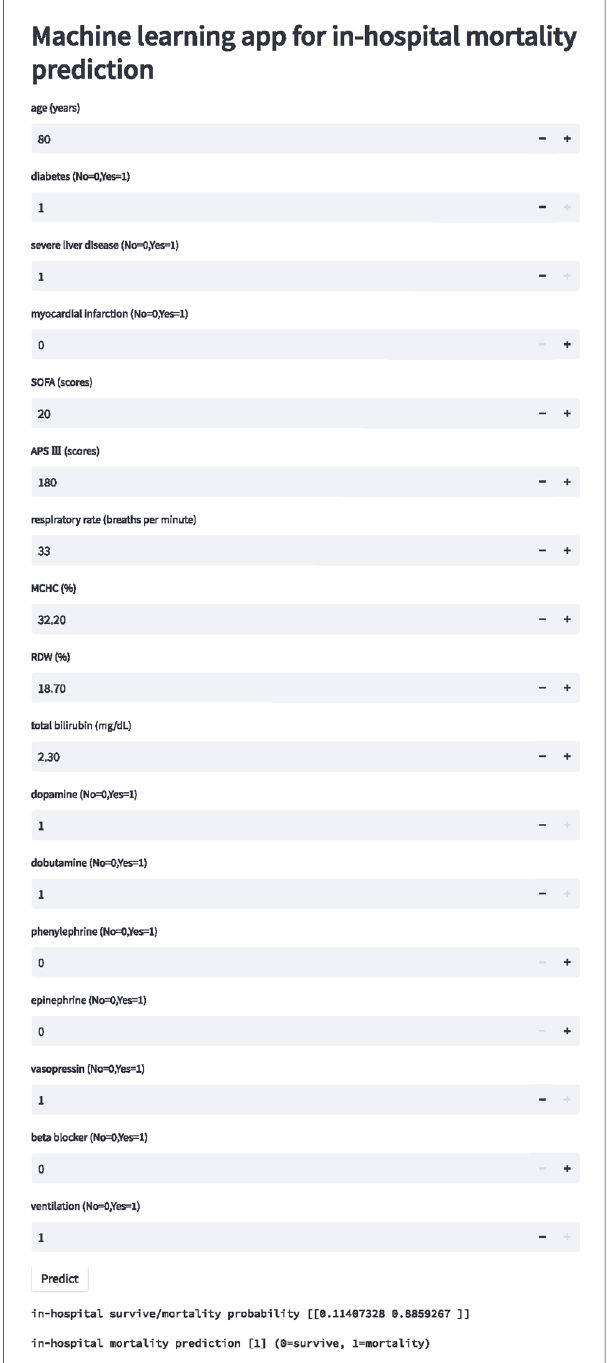
FIGURE 6 Schematic diagram of online website calculator for the mortality prediction in all ICU patients with congestive heart failure. Input the patient information and click the “ predict ” button to get the patient ’ s in-hospital mortality risk assessment